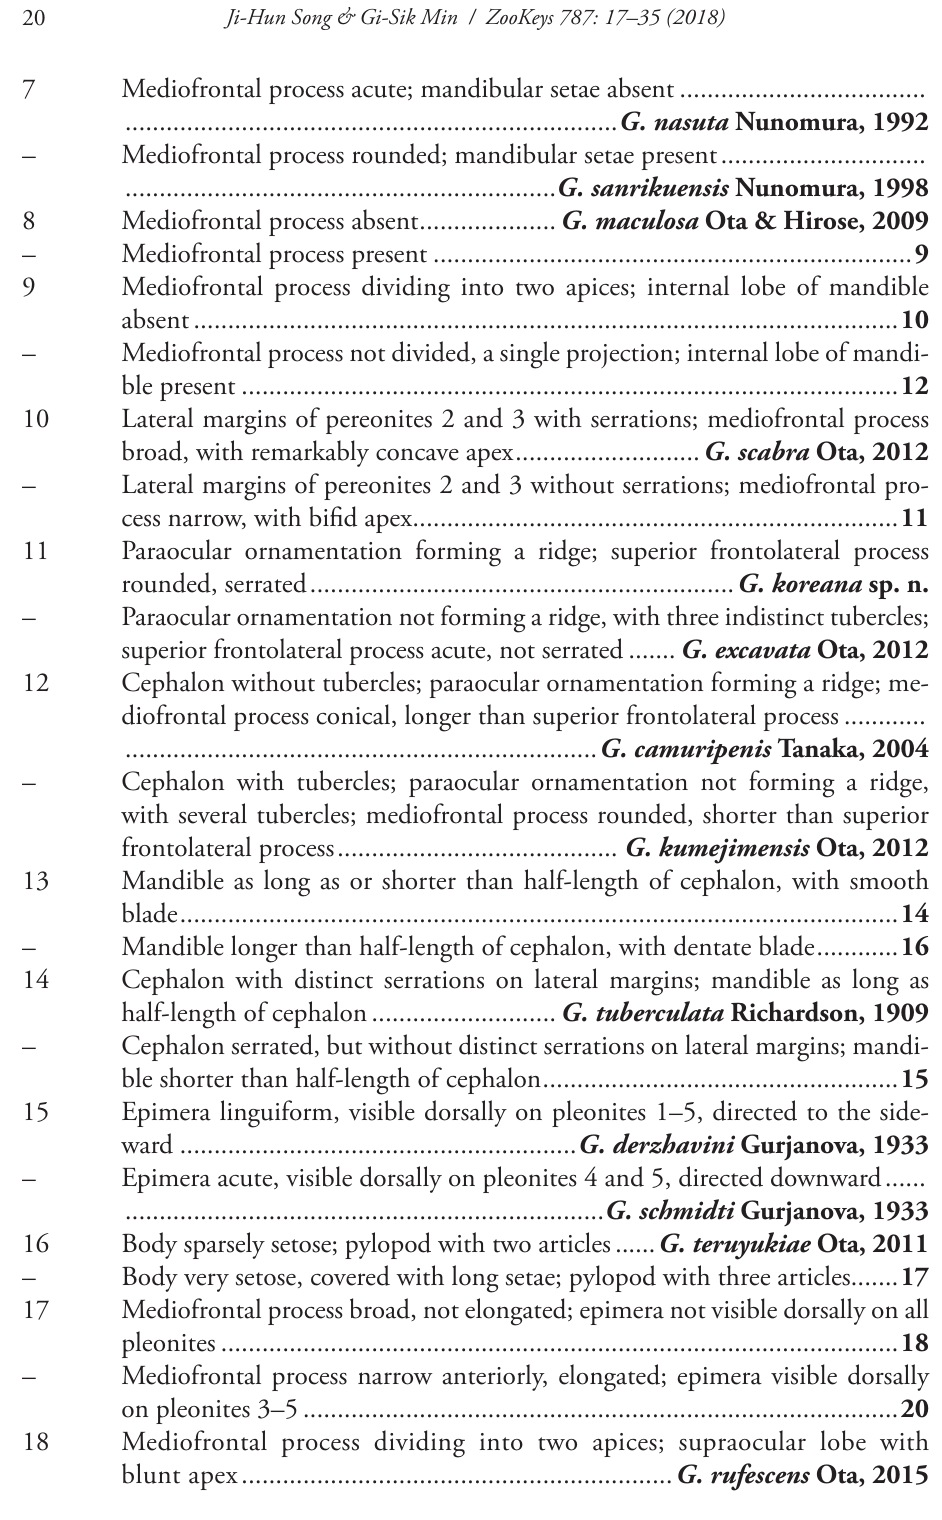
9 Mediofrontal process dividing into two apices; internal lobe of mandible – Mediofrontal process not divided, a single projection; internal lobe of mandi- 10 Lateral margins of pereonites 2 and 3 with serrations; mediofrontal process – Lateral margins of pereonites 2 and 3 without serrations; mediofrontal pro- 11 Paraocular ornamentation forming a ridge; superior frontolateral process – Paraocular ornamentation not forming a ridge, with three indistinct tubercles; superior frontolateral process acute, not serrated ....... G. excavata Ota, 2012 12 Cephalon without tubercles; paraocular ornamentation forming a ridge; me- diofrontal process conical, longer than superior frontolateral process ............ – Cephalon with tubercles; paraocular ornamentation not forming a ridge, with several tubercles; mediofrontal process rounded, shorter than superior 13 Mandible as long as or shorter than half-length of cephalon, with smooth – Mandible longer than half-length of cephalon, with dentate blade ............ 16 14 Cephalon with distinct serrations on lateral margins; mandible as long as half-length of cephalon ........................... G. tuberculata Richardson, 1909 – Cephalon serrated, but without distinct serrations on lateral margins; mandi- ble shorter than half-length of cephalon .................................................... 15 15 Epimera linguiform, visible dorsally on pleonites 1–5, directed to the side- – Epimera acute, visible dorsally on pleonites 4 and 5, directed downward ...... 16 Body sparsely setose; pylopod with two articles ...... G. teruyukiae Ota, 2011 – Body very setose, covered with long setae; pylopod with three articles....... 17 17 Mediofrontal process broad, not elongated; epimera not visible dorsally on all – Mediofrontal process narrow anteriorly, elongated; epimera visible dorsally 18 Mediofrontal process dividing into two apices; supraocular lobe